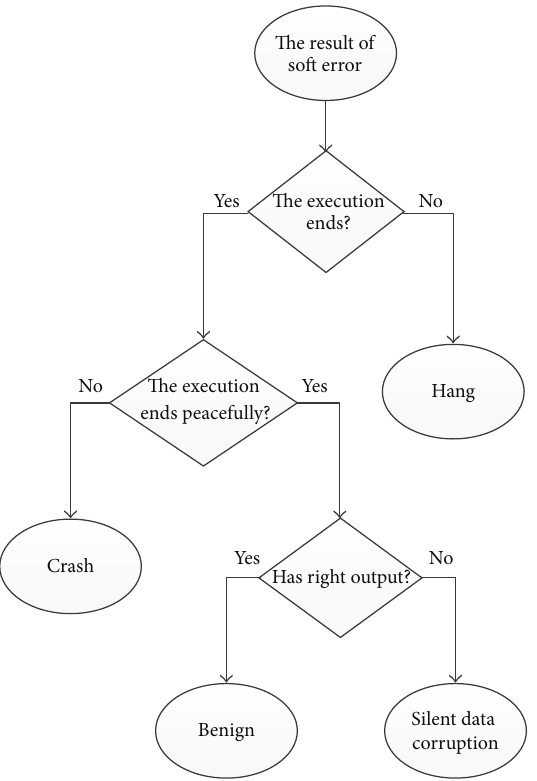
Figure 1: Classification of the result of soft